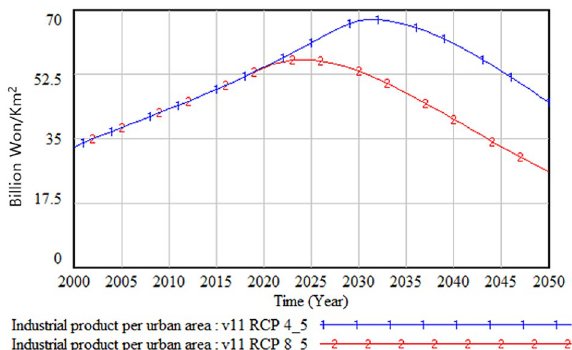
Figure 21. Industrial output per unit of urban area.